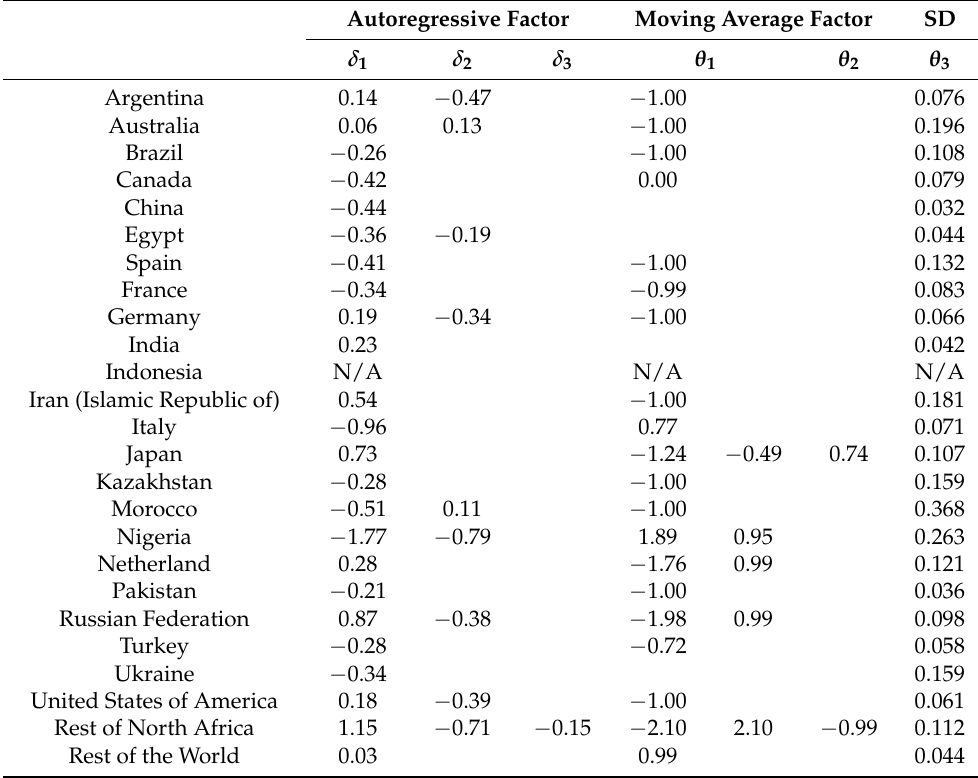
Table 2. Results of the autoregressive integrated moving average (ARIMA)